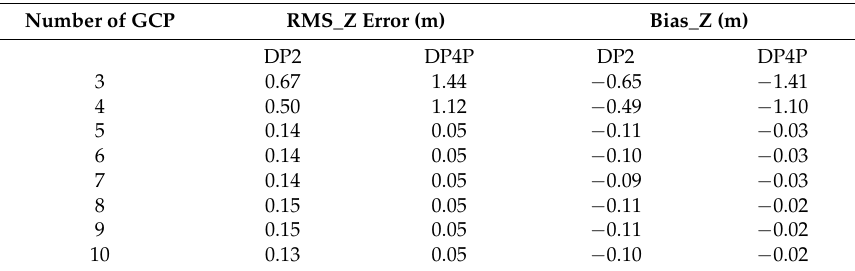
Table 1. DSM RMS_Z error and Bias_Z calculated at the validation points for DP2 and DP4P using different numbers of GCPs.